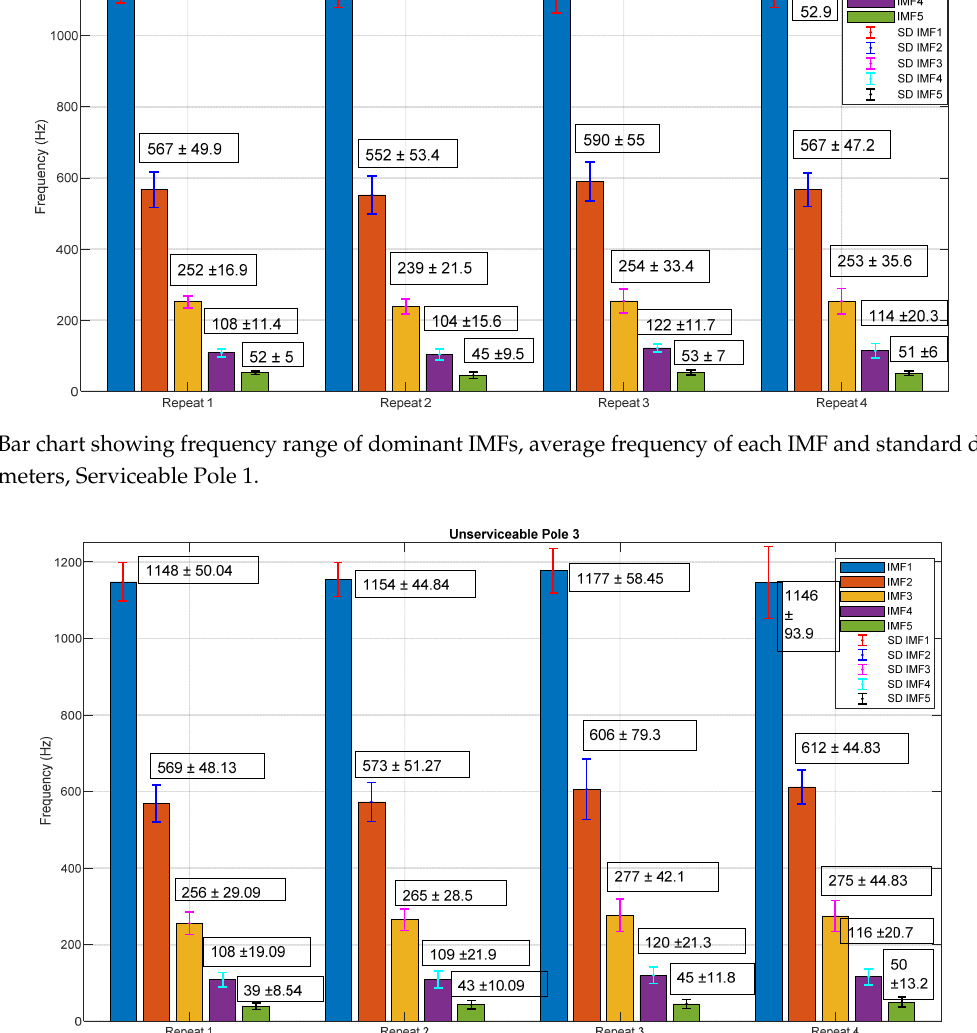
Figure 19. Bar chart showing frequency range of dominant IMFs, average frequency of each IMF and standard deviation for 12 accelerometers, Unserviceable Pole 3.